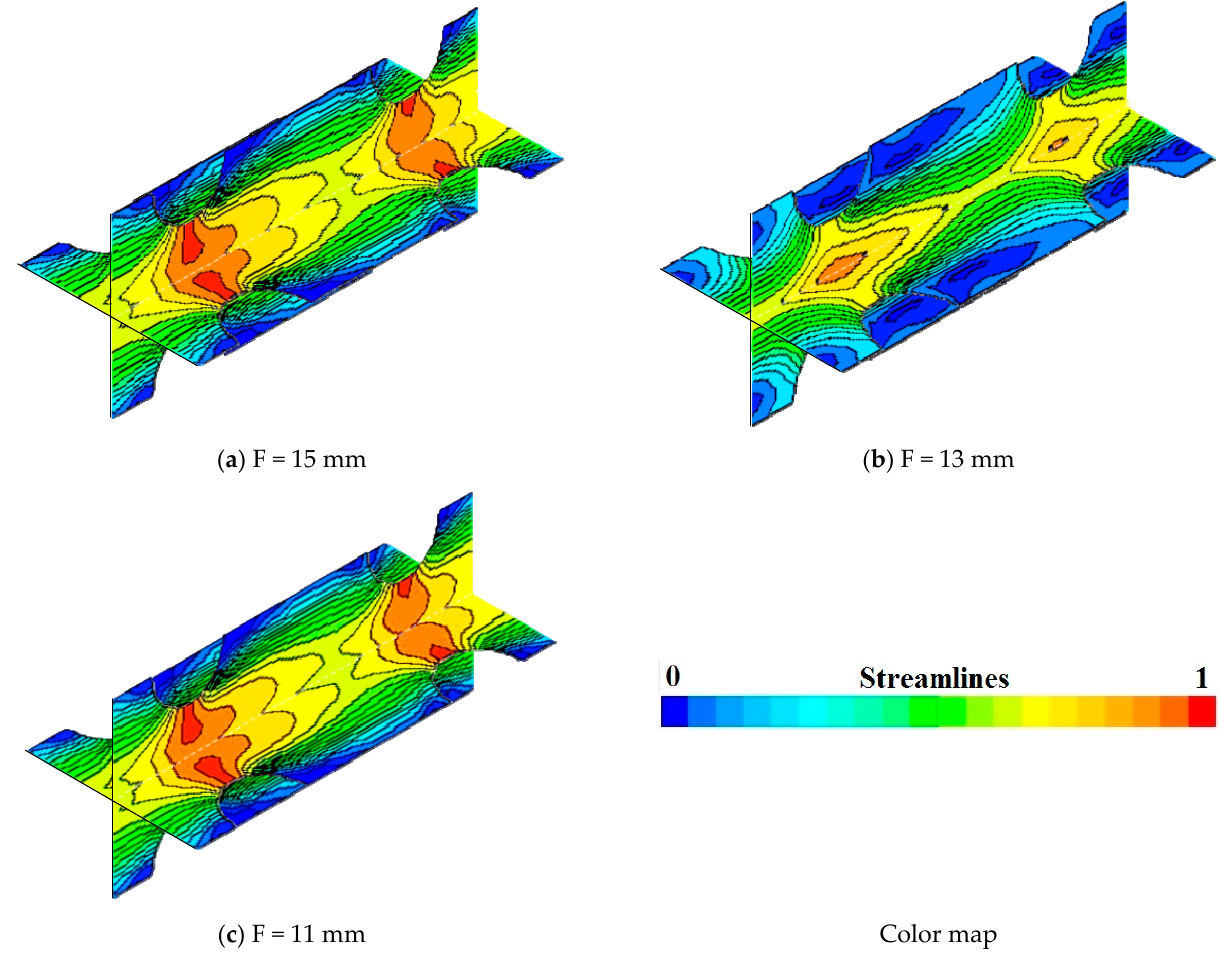
Figure 28. Streamlines for various configurations of Case F with different F parameters at Re = 15,000, and 𝜑 = 0.5%.